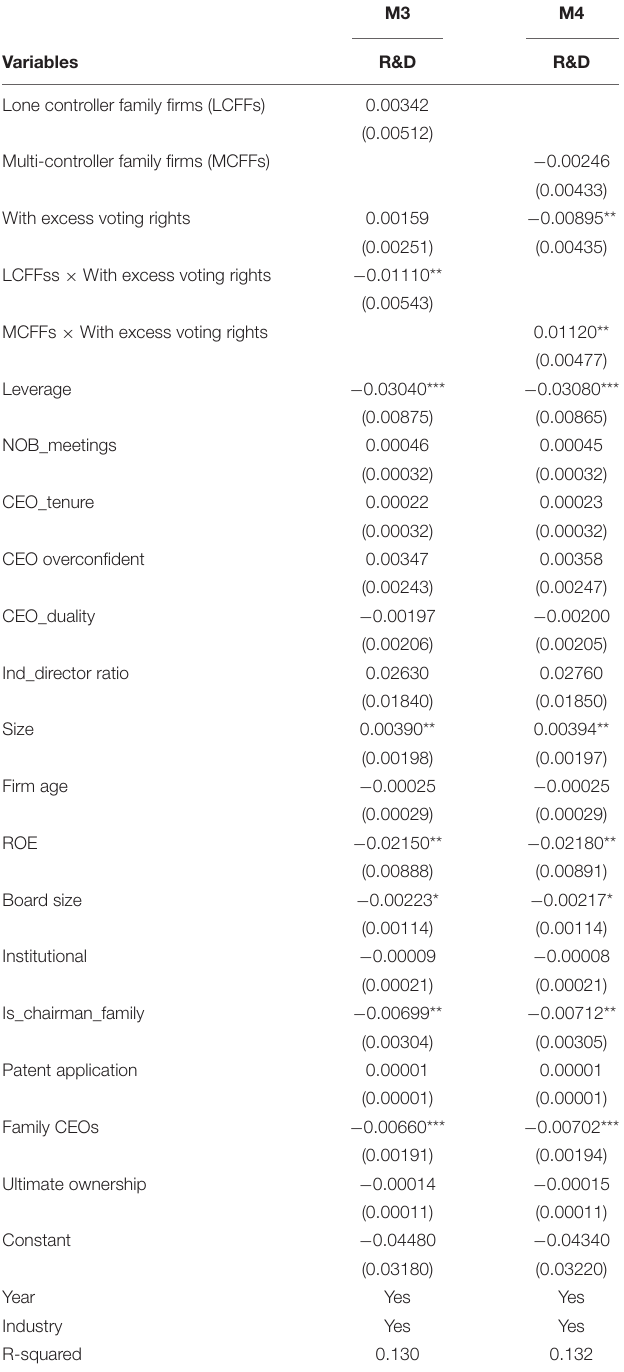
TABLE 1 | Regression results with binary (dummy) moderating